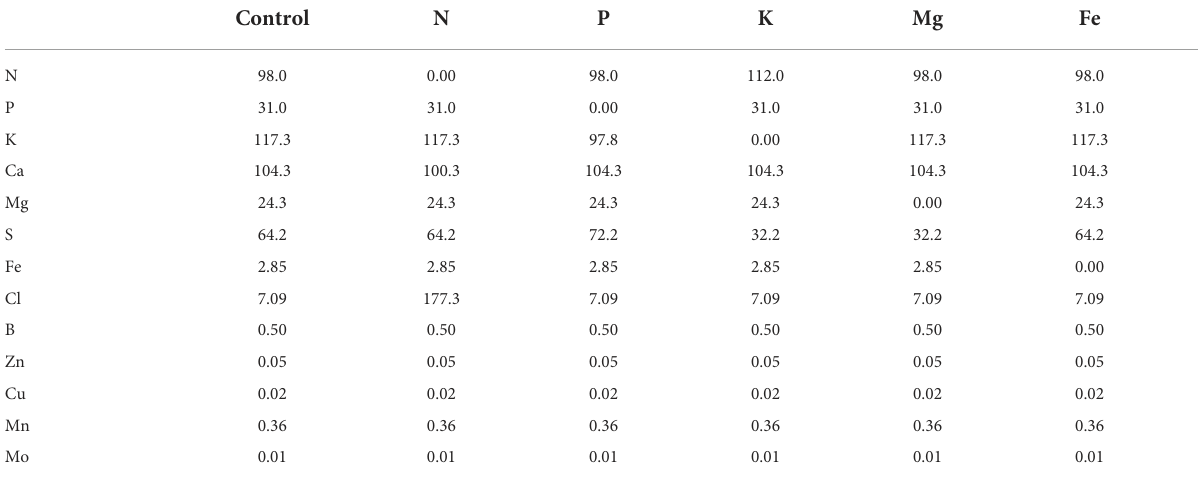
TABLE 2 The concentration of plant nutrients in treatment solutions. Plant nutrient The concentration of nutrients in final (treatment) solutions (mg L − 1 ) Control